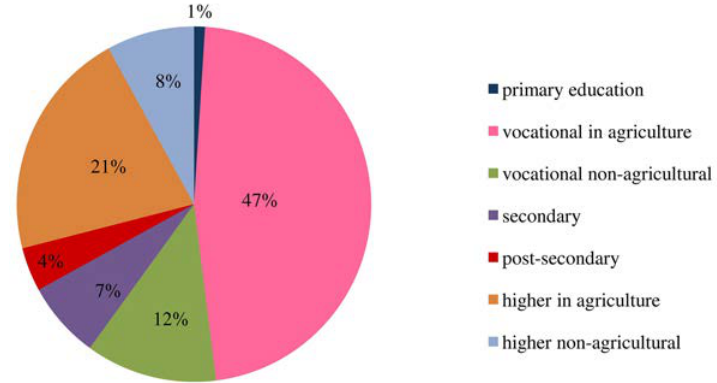
Fig. 4. The educational structure of the respondents. Source: own